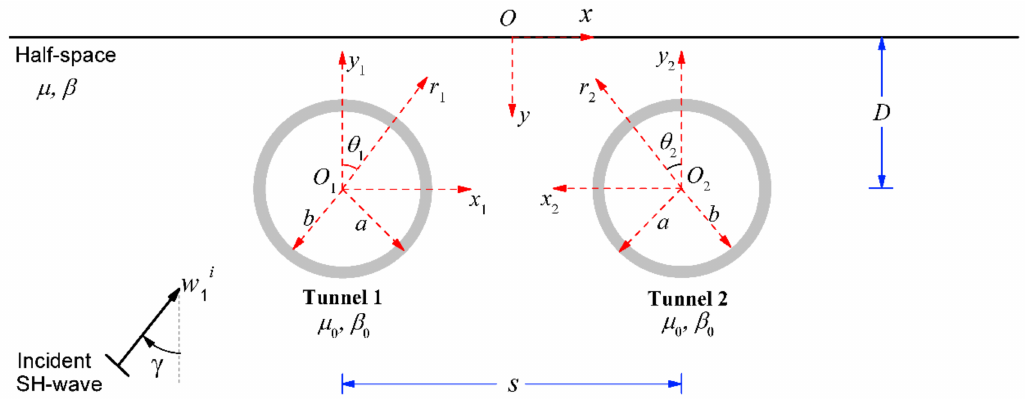
Figure 1. The analytical model of dynamic tunnel-soil-tunnel interaction subjected to out-of-plane